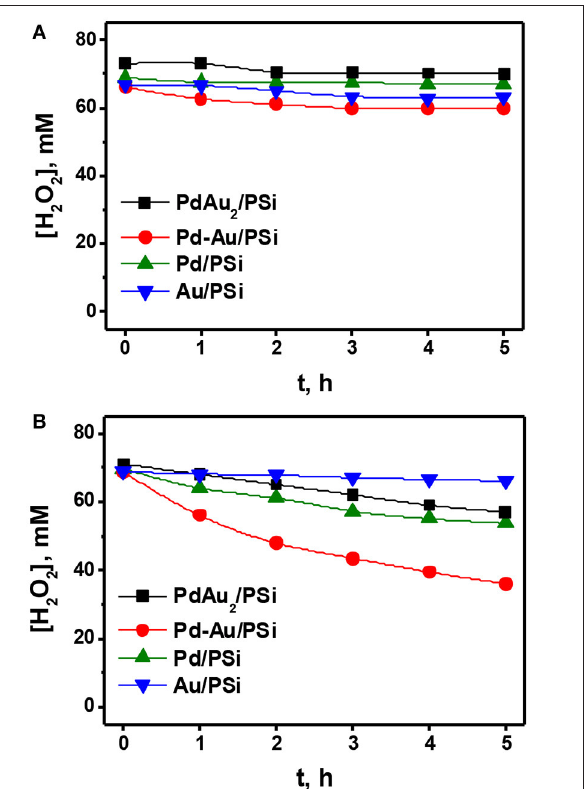
FIGURE 7 | The time course of the H 2 O 2 concentration for the H 2 O 2 decomposition (A) and reduction (B) over the Pd/PSi, Au/PSi, Pd-Au/PSi and PdAu 2 /PSi catalysts. P = 1 bar. T = − 10 ◦ C. Reaction media: 100mL of a ca. 70 mM/0.03M H 2 SO 4 methanol solution. Gas flow rate: (A) 50ml (STP) min − 1 He; (B) 2ml (STP) min − 1 H 2 ; and 48ml (STP) min − 1 He. Catalyst loading: